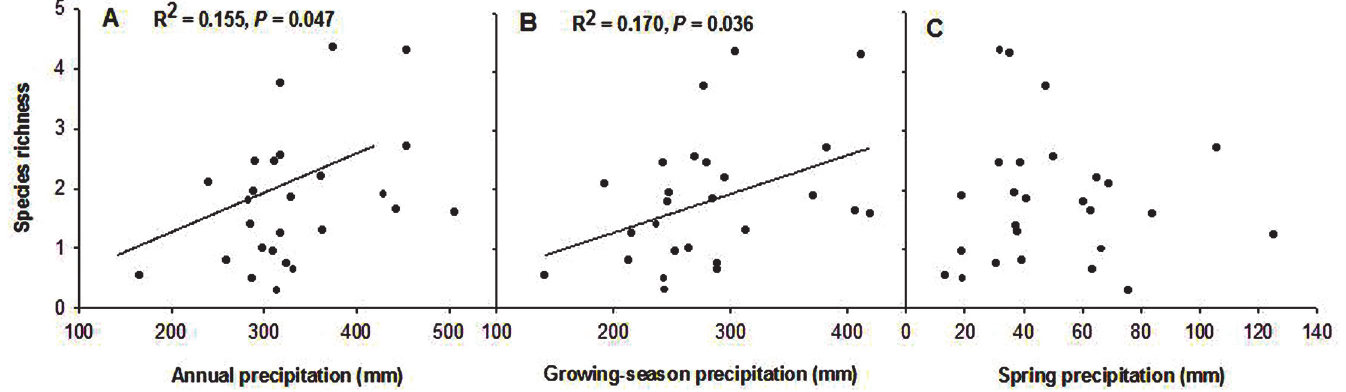
Fig 5. Relationship between species richness of annuals and precipitation. (A) Annual precipitation; (B) Growing-season precipitation; (C) Spring precipitation.